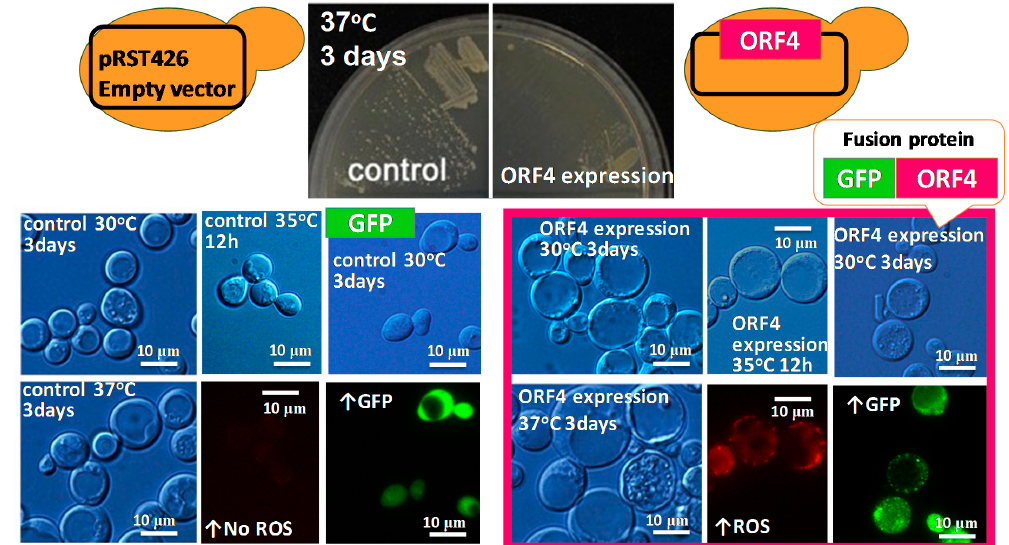
Figure 8. Expression of the MoCV1 ‐ A ORF4 protein induced cytological damage in yeast ( S. cerevisiae ) cells. The MoCV1 ‐ A ORF4 gene was inserted in a high ‐ expression vector (2 μ ori, TDH3 promoter) cells. The MoCV1-A ORF4 gene was inserted in a high-expression vector (2 µ ori, TDH3 promoter) and the vector was used to transform the yeast strain, W303 ‐ 1A. The morphology and growth of the yeast cells were observed. The MoCV1 ‐ A ORF4 ‐ GFP fusion protein caused aggregation in the yeast cells.